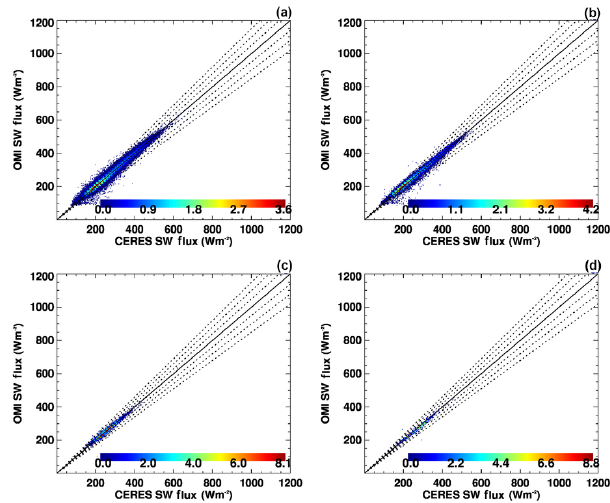
Figure 9. Similar to Fig. 8 but for monthly mean data (July 2007) OMI and CERES TOA SW flux averaged over different spatial grid sizes: (a) 0.5 ◦ × 0.5 ◦ ; (b) 1 ◦ × 1 ◦ ; (c) 2 ◦ × 2 ◦ ; (d) 5 ◦ × 5 ◦ . The corresponding statistical parameters are listed in Table 2. The three dotted lines are 5, 10, and 15% error envelope lines.